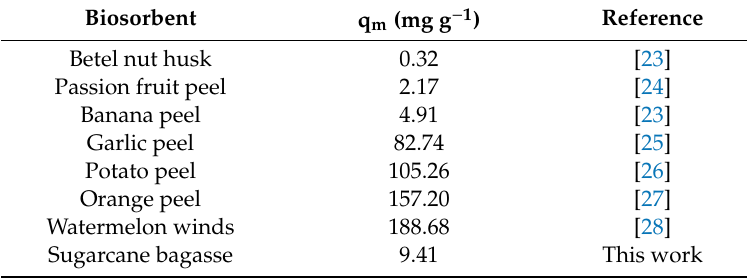
Table 3. Comparison of biosorption capacities of methylene blue (MB) on various agroindustrial by-products.